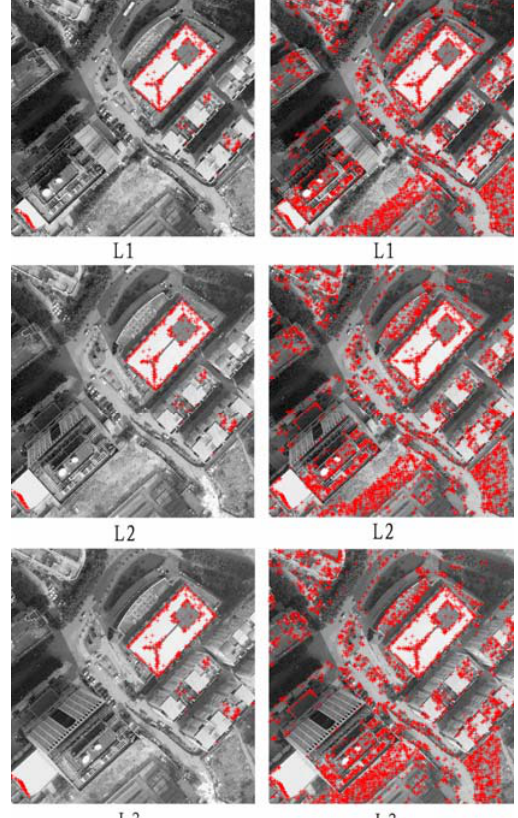
Figure 3. The matching results of grid cells as number=3 on Figure 4. The matching results of the best grid cells as